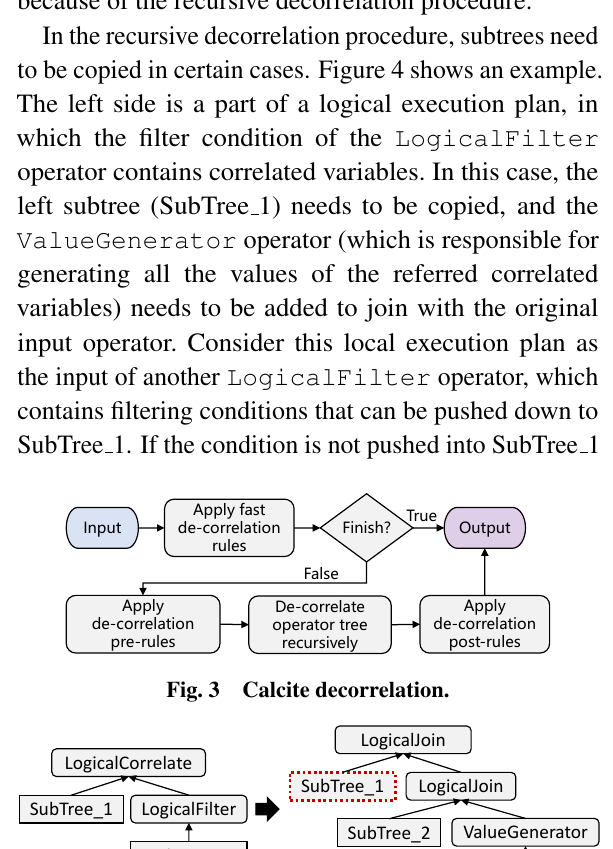
Fig. 3 Calcite decorrelation.